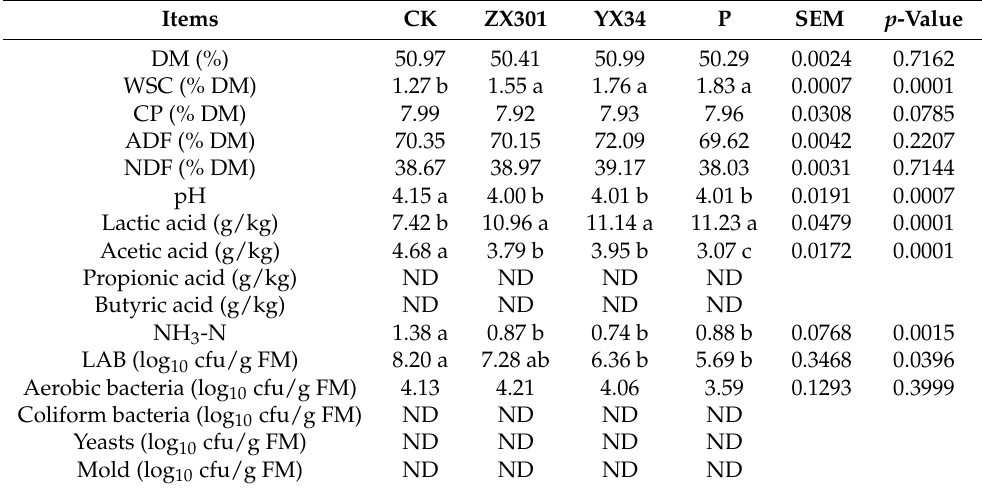
Table 5. Effects of additives on chemical composition, fermentation quality, and microbial composi- tions of Stipa grandis silage after 60 days.